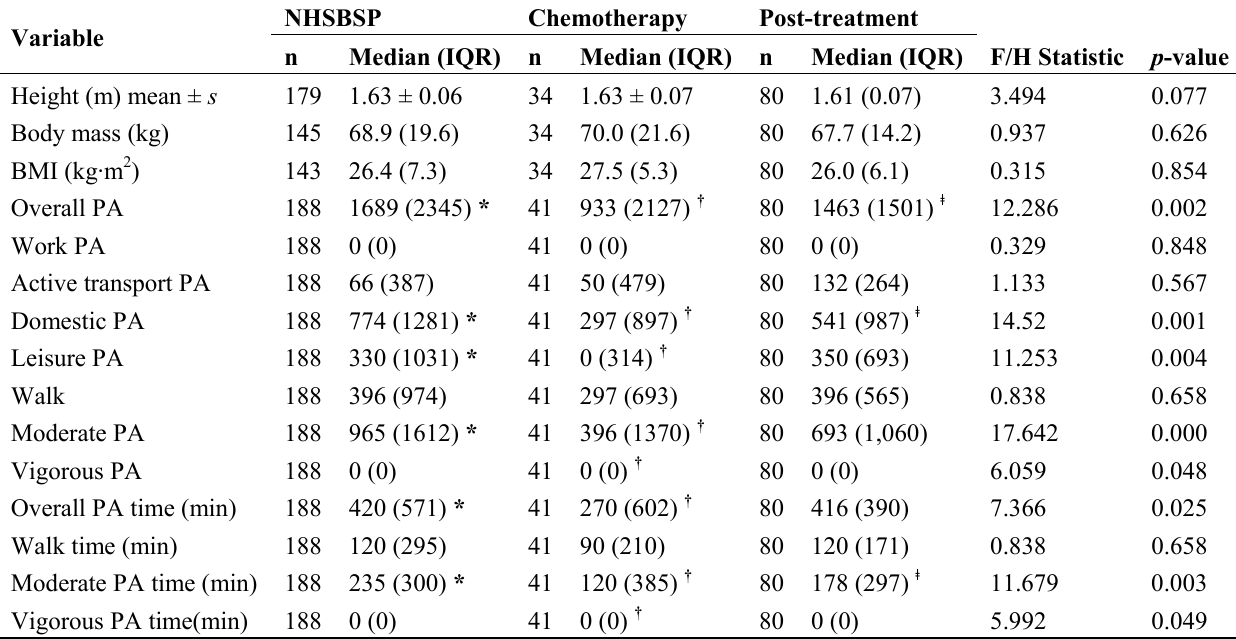
Table 2. Mean ± s or median (interquartile range) for anthropometric measures and physical activity (PA) variables for NHSBPS participants, breast cancer patients undergoing chemotherapy, and breast cancer patients within one-year post-treatment (PA in MET-min·wk − 1 unless stated